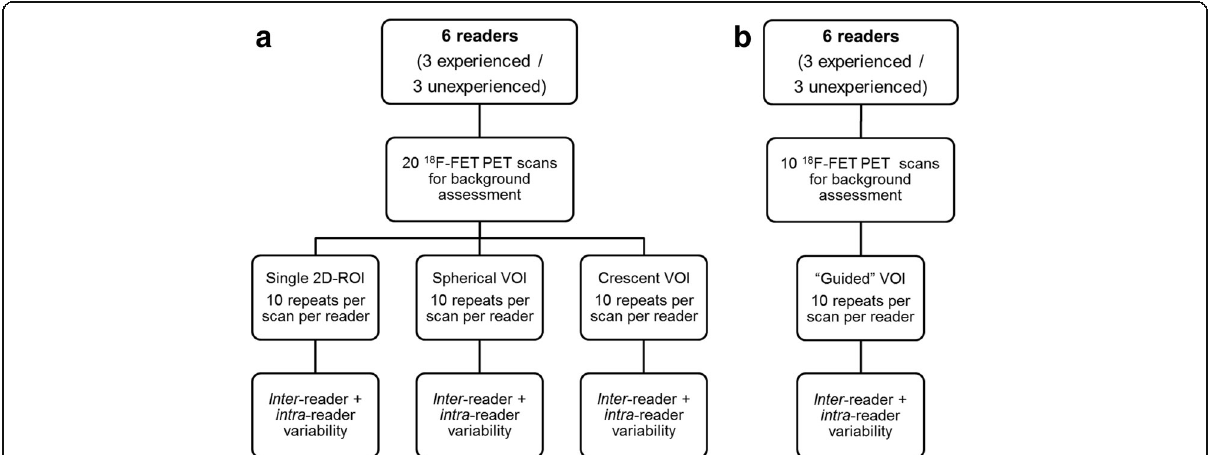
Fig. 1 Procedural outline. a Evaluation of three commonly used methods for background assessment, b evaluation of the best method of a with